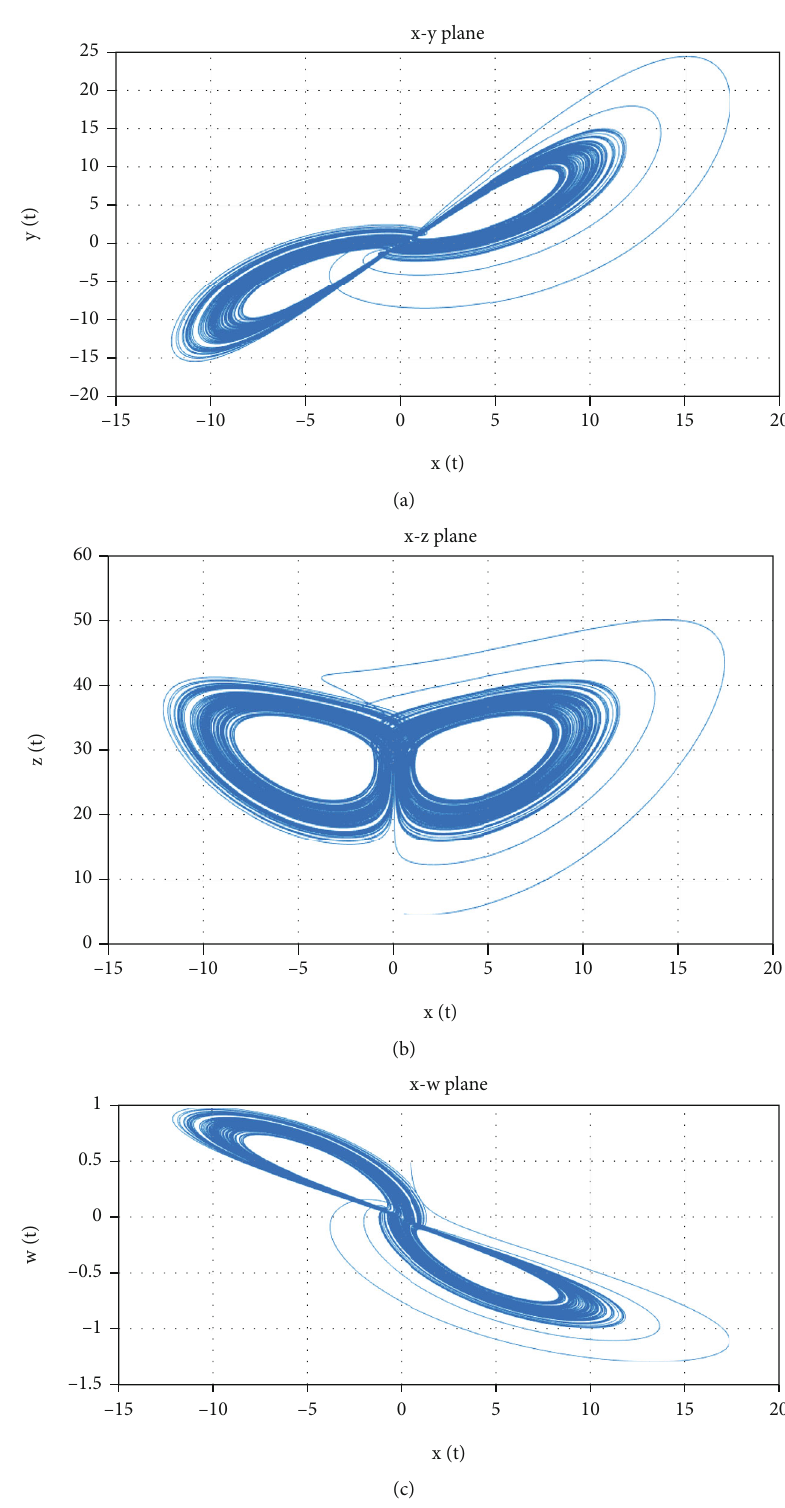
Figure 8: Attractors of the LS system (5) for r = 30 : 4 projected on the planes: (a) x - y , (b) x - z , and (c) x - w